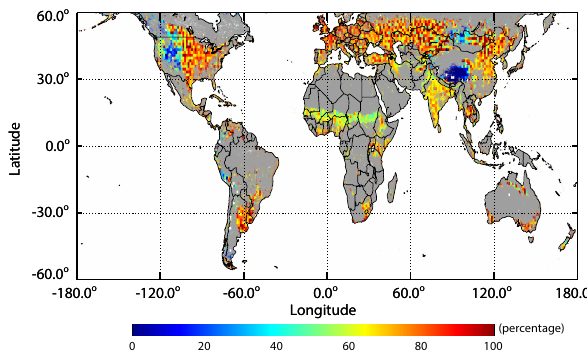
Figure 7. Global distributions of the percentage of anthropogenic dust column burden account for total dust column